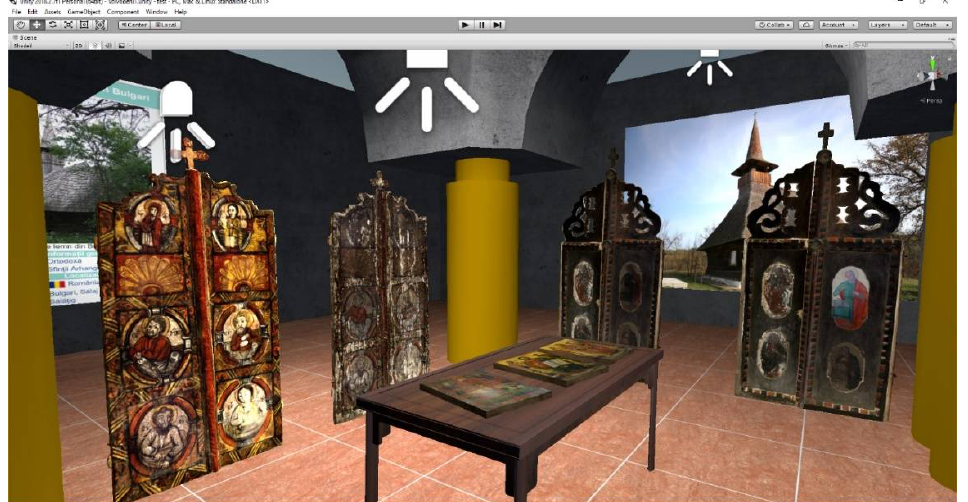
Figure 18. The imperial gates from Voivodeni positioned within the virtual reality environment.